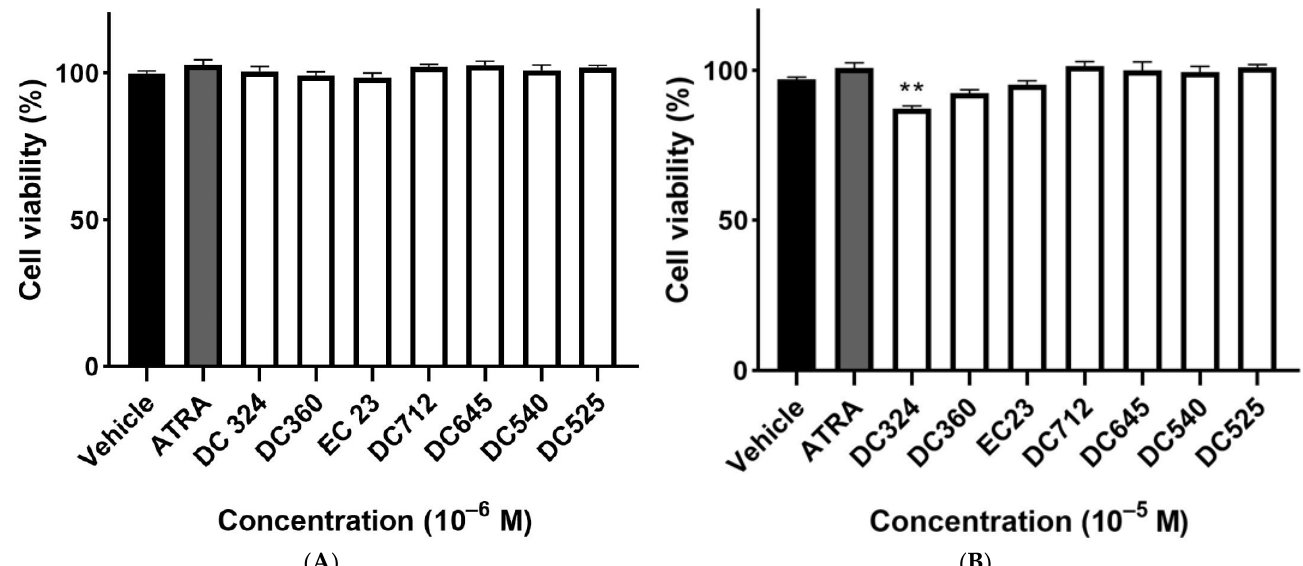
Figure 2. Viability of CHO cells. Cells were exposed to ATRA or its synthetic analogues in 10 − 6 M ( A ) or 10 − 5 M ( B ) for 24 h and cell viability was detected by the ATP viability assay as a percentage of the vehicle-treated control. Each column represents the mean ± SEM of n=12 experiments performed in two independent series (** p < 0.01 vs. vehicle).